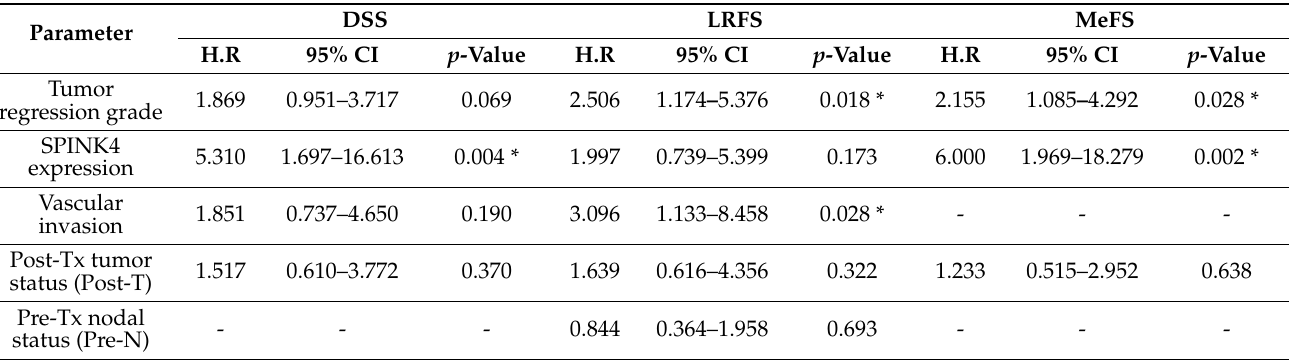
Table 4. Multivariate